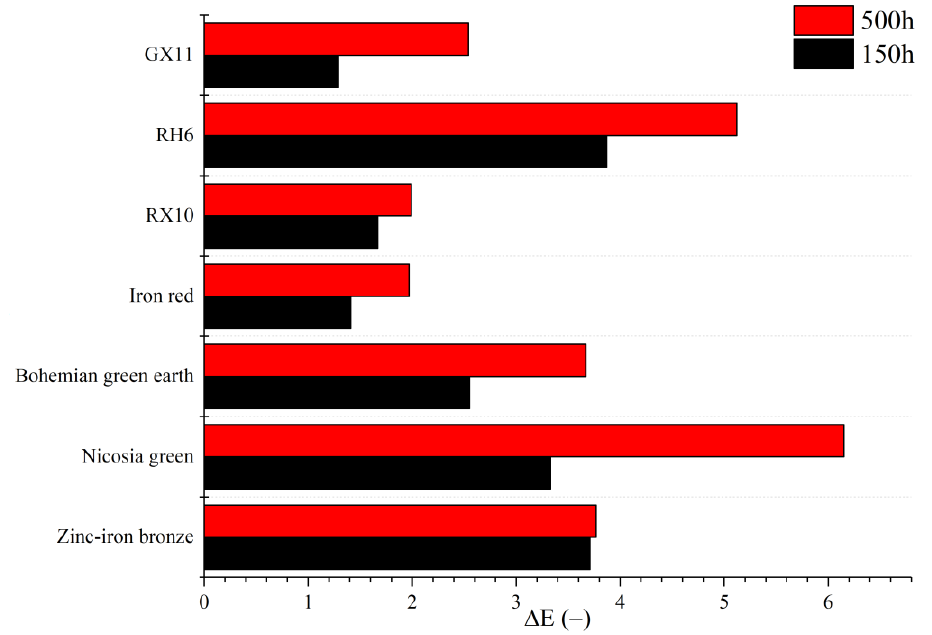
Figure 5. Color change (ΔE) of paint samples exposed to different durations of UV